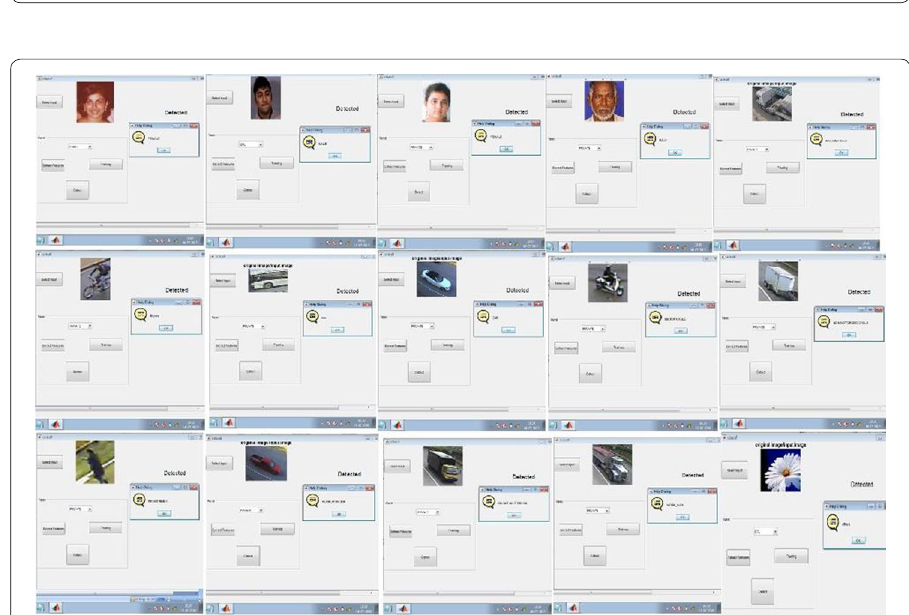
Fig. 7 User interface design for uploading the image to classify